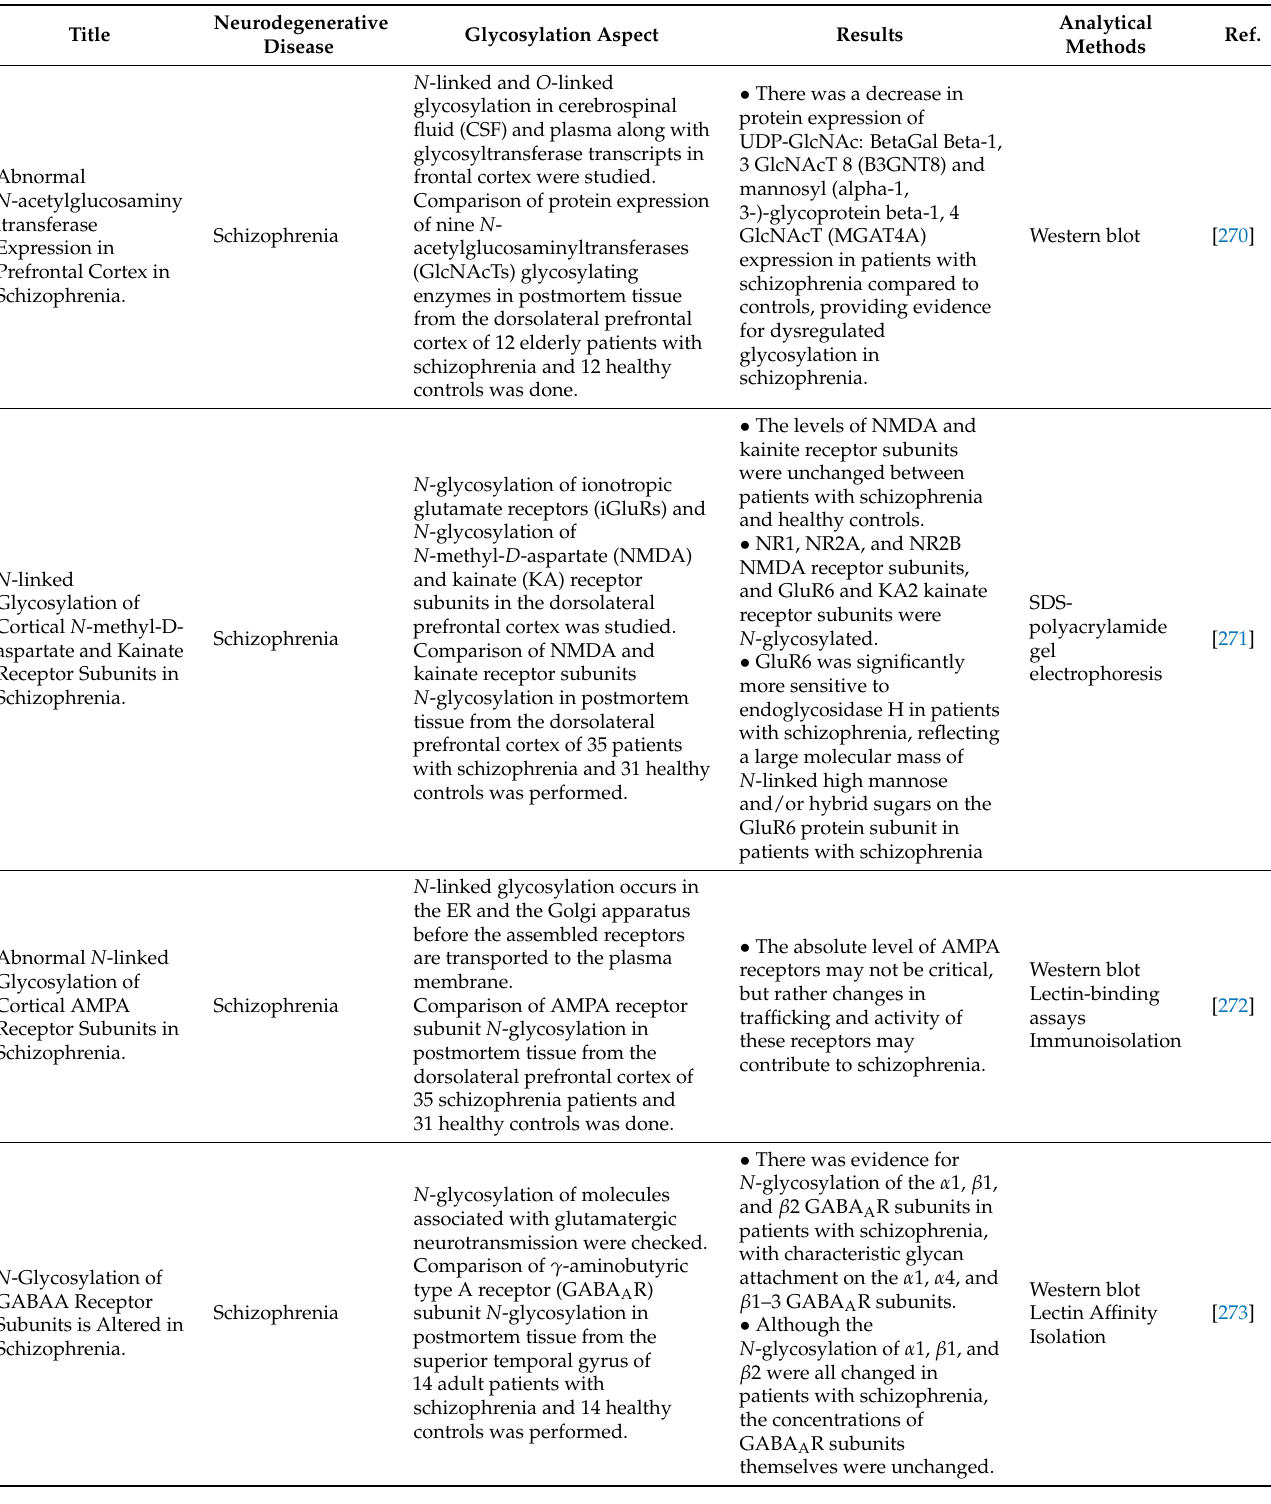
Table 4. An overview of the alterations in the normal glycosylation patterns occurring in Schizophre- nia, a neuropsychiatric disorder, along with the subsequent consequences on other protein expression